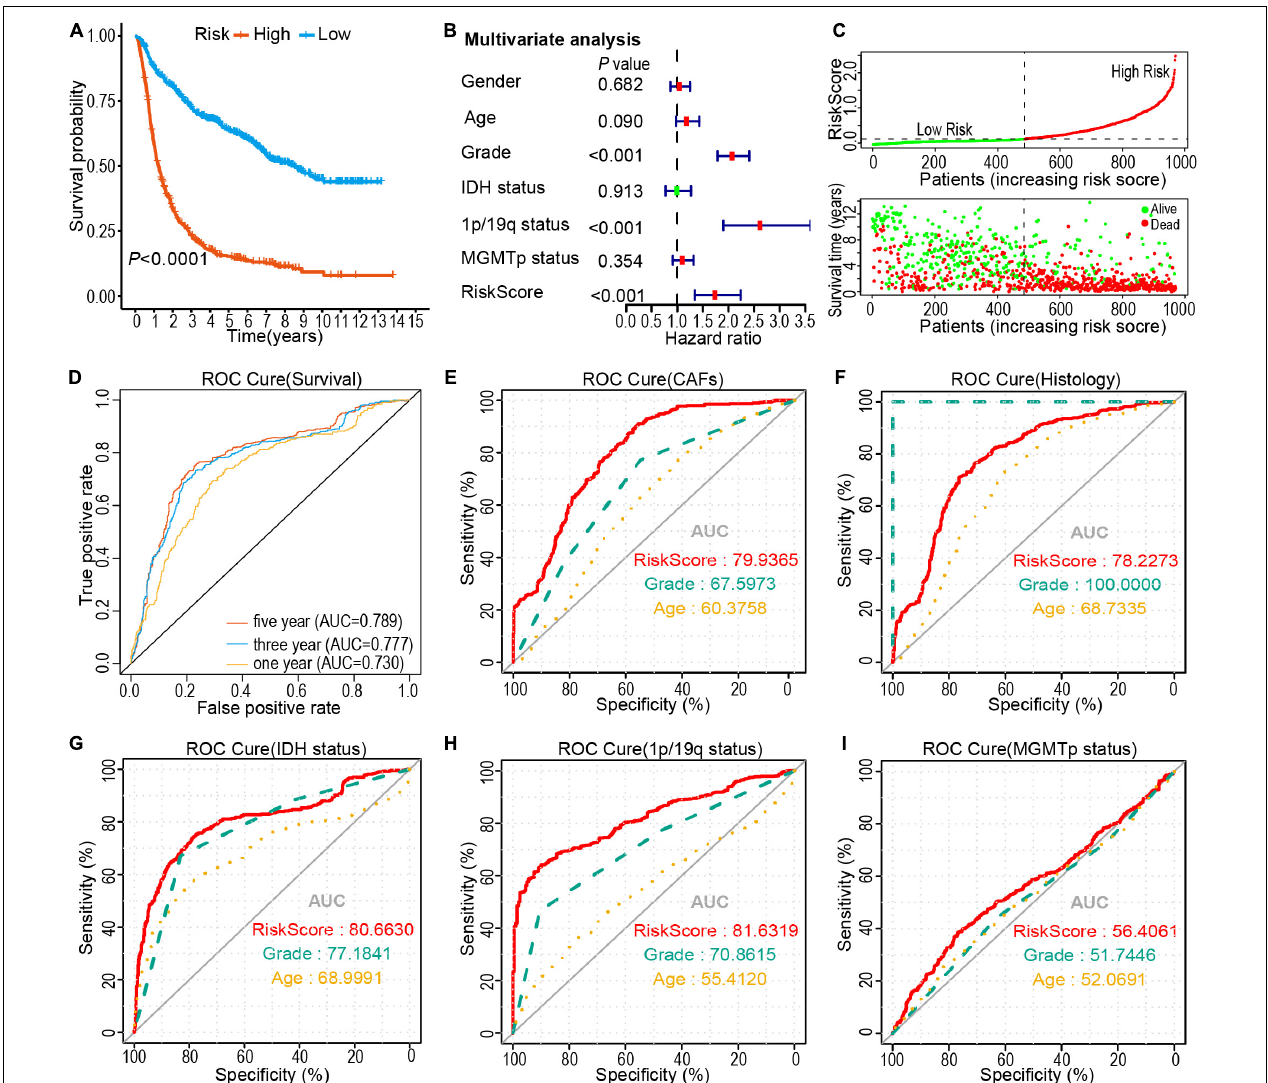
FIGURE 4 | Prognostic significance of risk signature derived risk score in the CGGA cohort. (A) Kaplan-Meier analysis of CGGA glioma patients was stratified by median risk. (B) Multivariate Cox regression analysis showed that the risk signature was an independent predictor of gliomas. (C) Risk score distribution, patient survival time, and glioma status. The black dotted line is the optimal threshold for classifying patients into low-and high-risk subtypes. (D–I) A high-risk score is associated with a lower survival rate for gliomas. ROC curves showed the predictive efficiency of risk characteristics, overall survival (D) , CAFs (E) , Histology (F) , IDH status (G) , 1p/19q status (H) , and MGMT promoter methylation status (I)